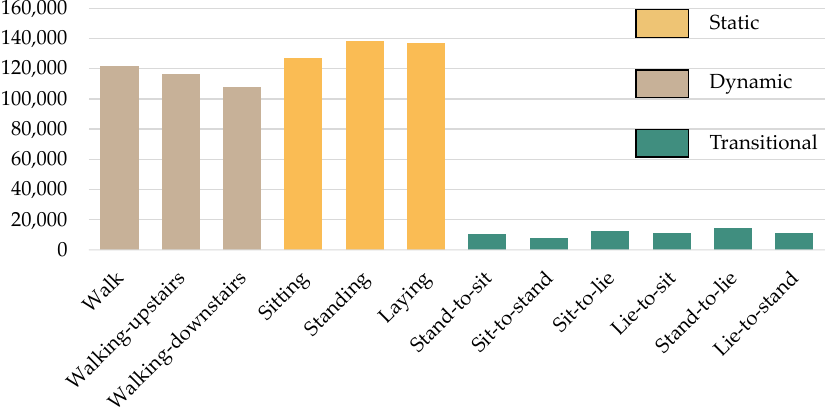
Figure 2. The number of activity samples in the HAPT